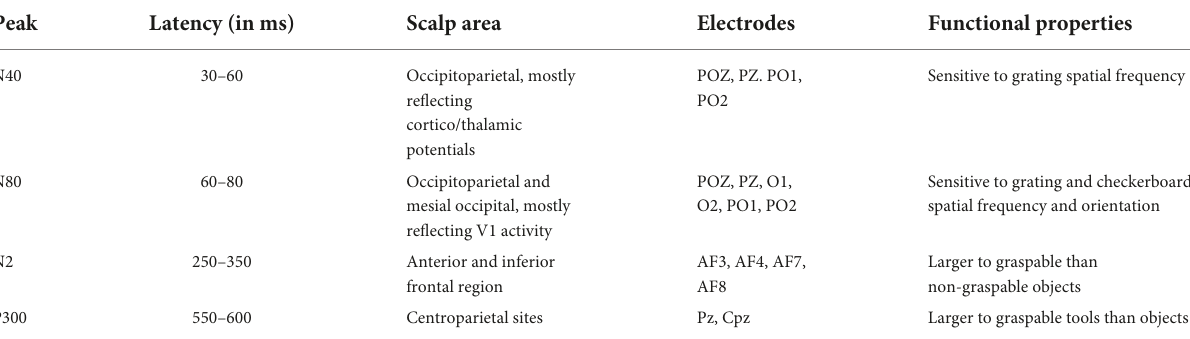
TABLE 4 ERP responses elicited by different categories object categories (Allison et al., 1999; Kenemans et al., 2000; Proverbio et al., 2011a, 2021; Orlandi and Proverbio,